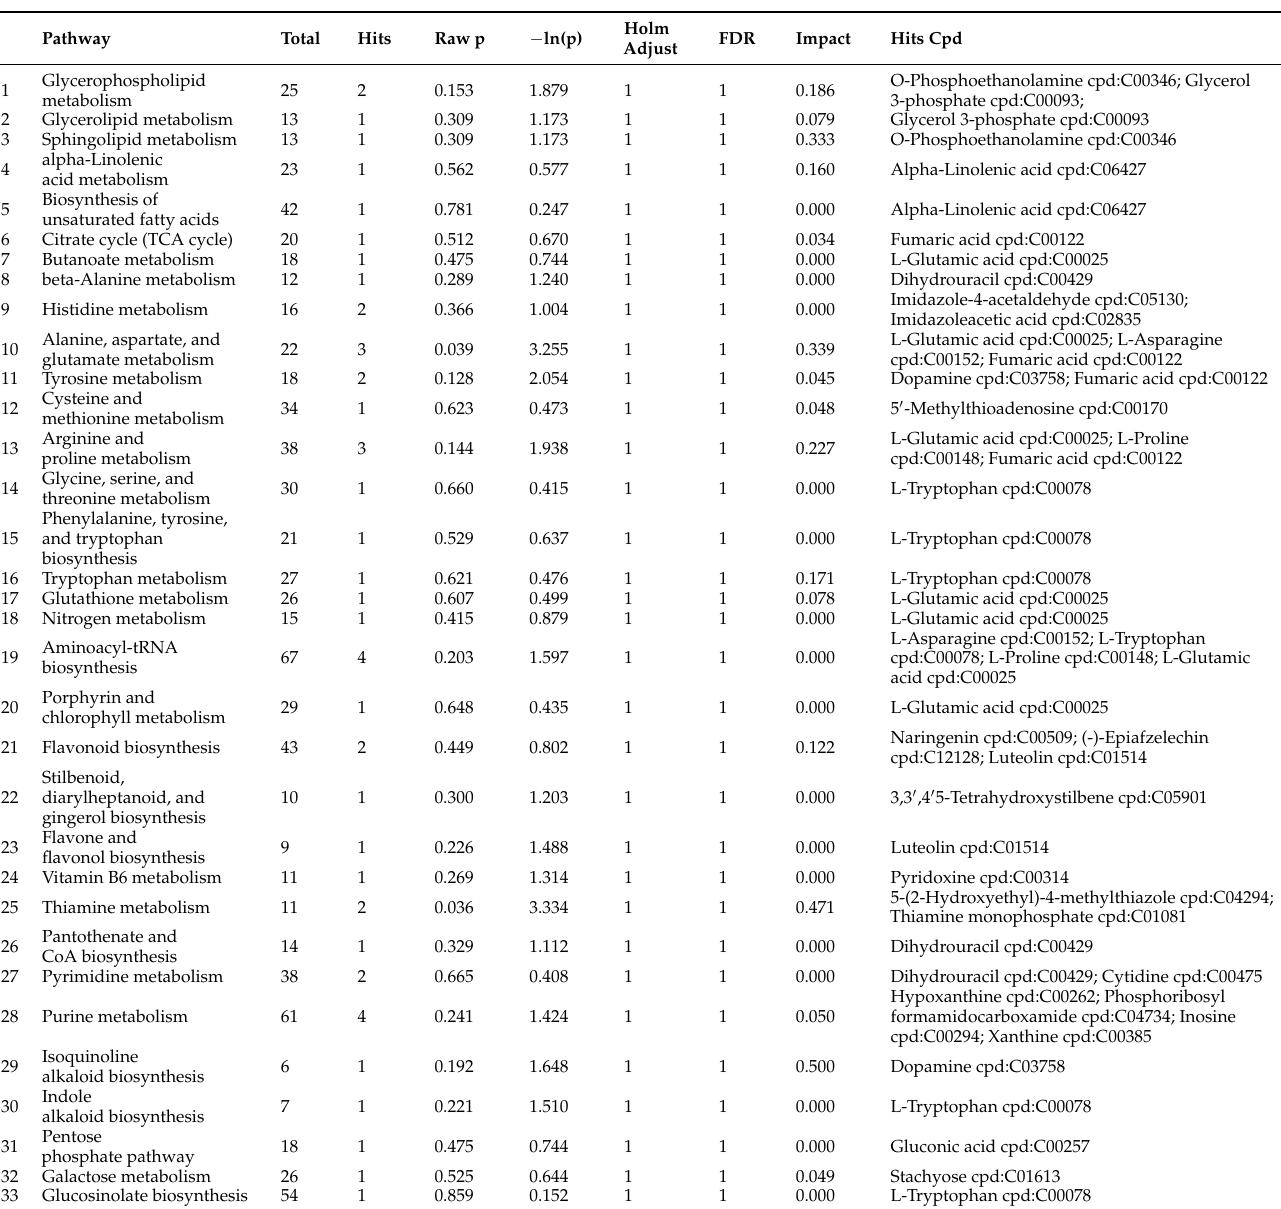
Table 2. Pathway analysis of different components of black beans following